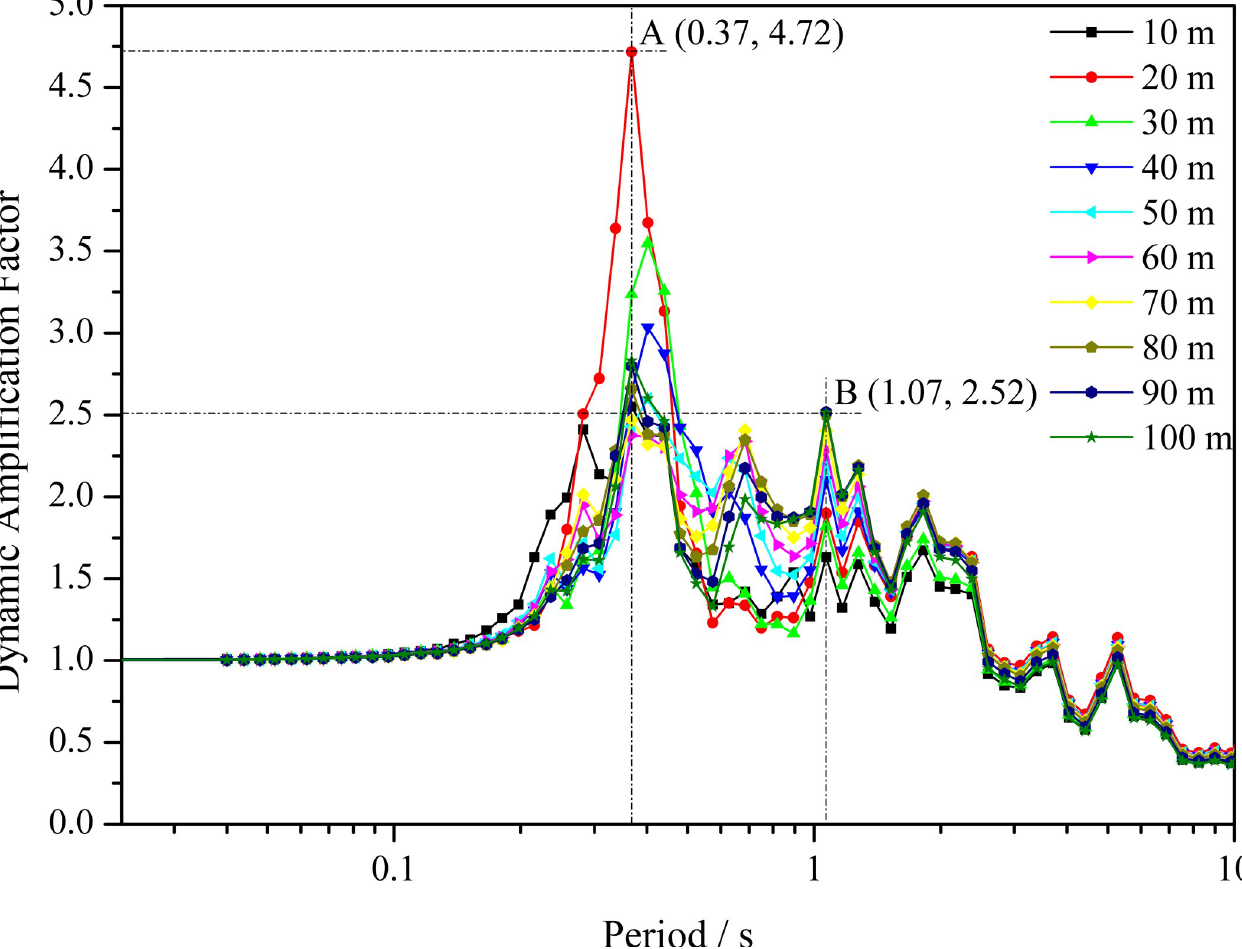
Fig 7. Acceleration spectrums under far field seismic ground